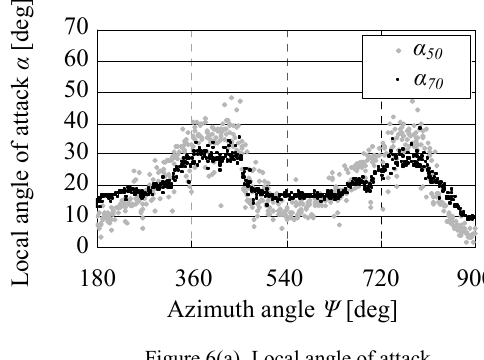
Figure 6(a). Local angle of attack